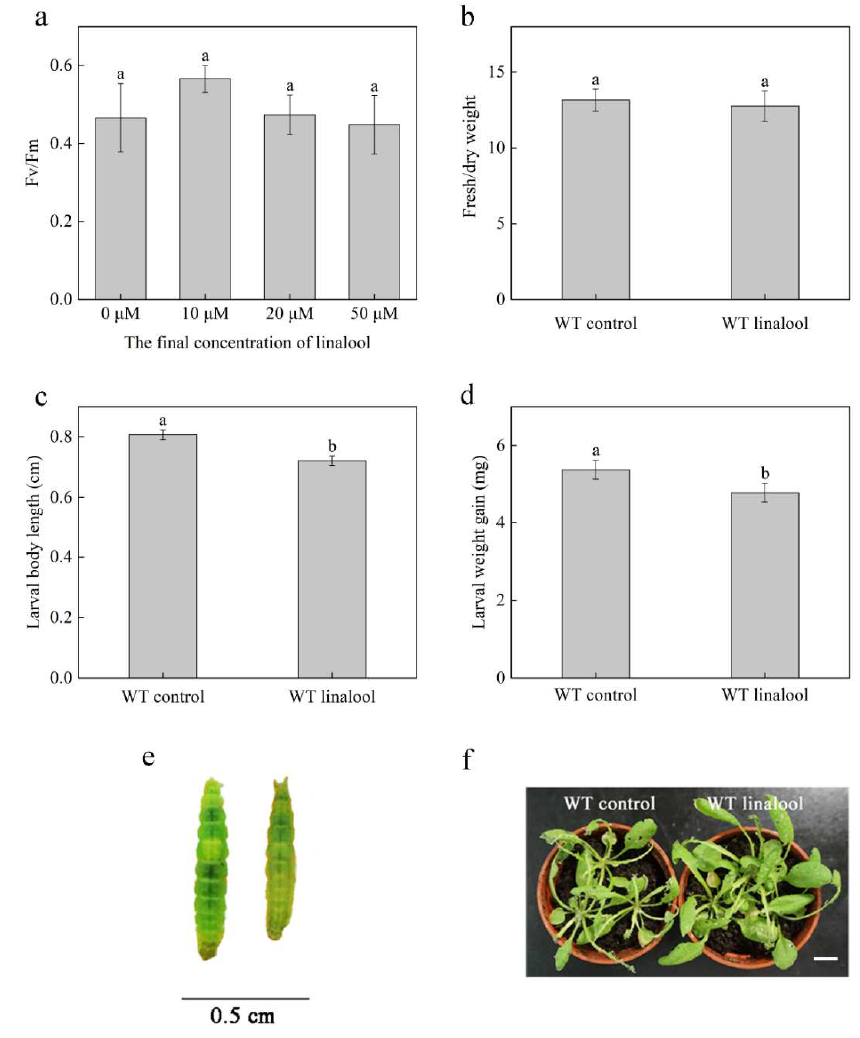
Figure 1. Arabidopsis plants show a linalool-induced plant defense against P. xylostella. ( a ) The maximal photochemical efficiency of Fv/Fm in different linalool treated groups. In the 0 μM control group, Arabidopsis plants were treated with ethyl alcohol. Additionally, in 10 μM, 20 μM, and 50 μM linalool groups, Arabidopsis plants were treated with linalool corresponding to the final concentrations. Error bars denote ± SEM, n = 6~8, p < 0.05, Dunnett’s C (variance not neat). ( b ) The ratio of fresh weight to dry weight. In the WT control group, Arabidopsis plants were treated with ethyl alcohol, and in the WT linalool group, Arabidopsis plants were treated with linalool at 20 μM final concentration. Error bars denote ± SEM (standard error of mean), n = 6~8, p < 0.05, Student’s t -test. ( c , d ) Larval body length and weight gain were measured 7 days after inoculation. Every pot had 3 Arabidopsis plants, 3 larvae were put in each plant, and each group (WT control and WT + linalool) contained approximately 25–40 larvae. Error bars denote ± SEM, n ≥ 25, and columns labeled with different letters are significantly different at p < 0.05, Student’s t -test. ( e ) Larvae phenotypes of the WT control (left) and WT + linalool (right). ( f ) Conditions of plants after 7 days of larval feeding. The plants were grown for 4 weeks (10 leaves). The scale bar represents 1